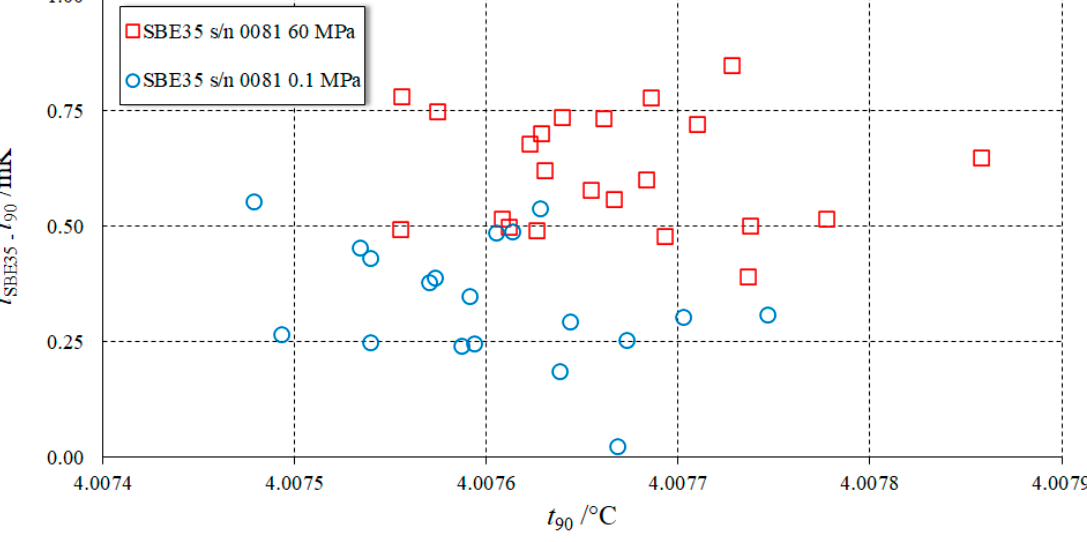
Figure 12. SBE35 s/n 0081 at 0.1 MPa and at 60 MPa. The experimental points at 60 MPa had clearly shifted up with respect to the experimental points at 0.1 MPa.